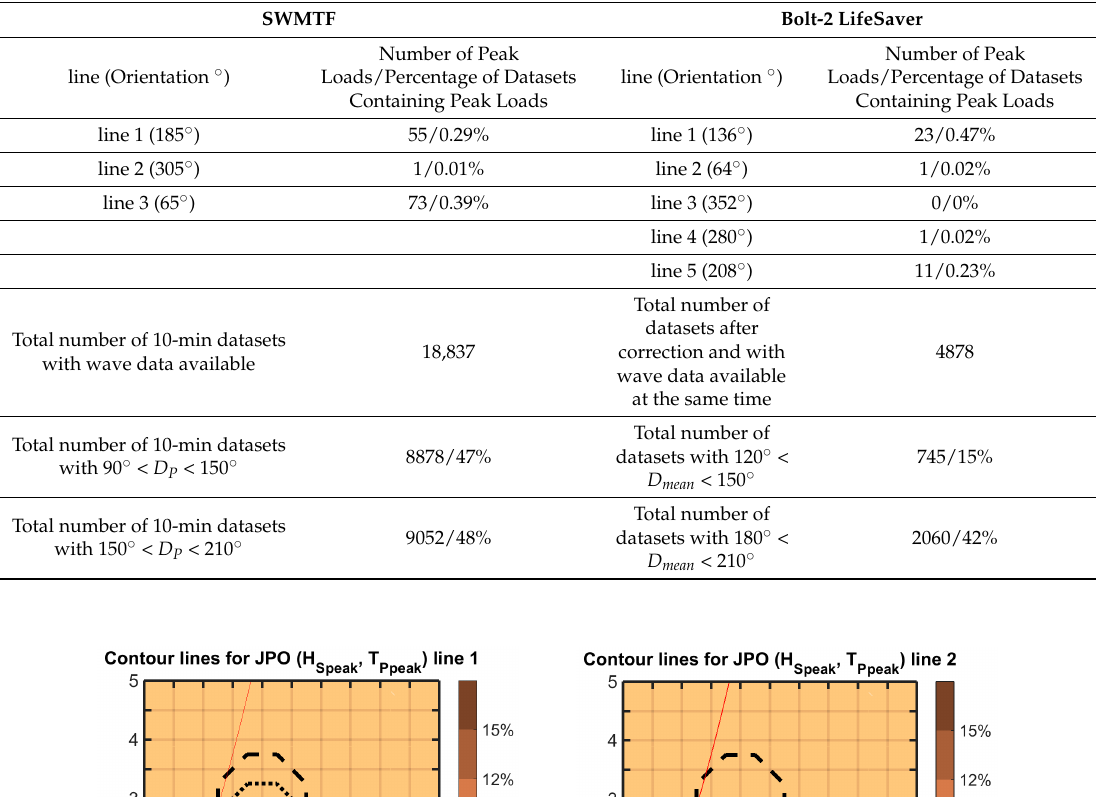
Table 6. Number/percentage of detected peak mooring loads for the SWMTF and the Bolt-2 Lifesaver device.